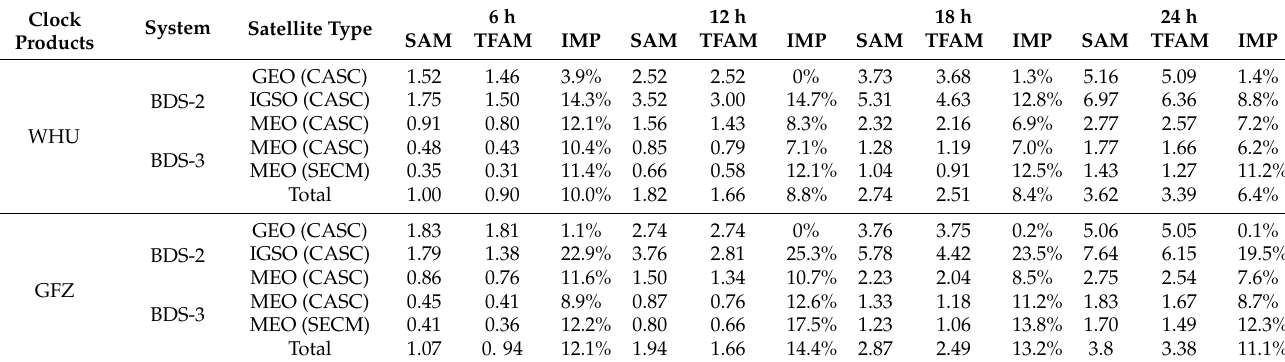
(DOY 140 to 169, 2021) are analyzed statistically. The mean RMS of 30 days for 30 satellites are listed in Table 3. Table 3. The mean prediction RMS based on the SAM and TFAM (unit: ns). Clock Products